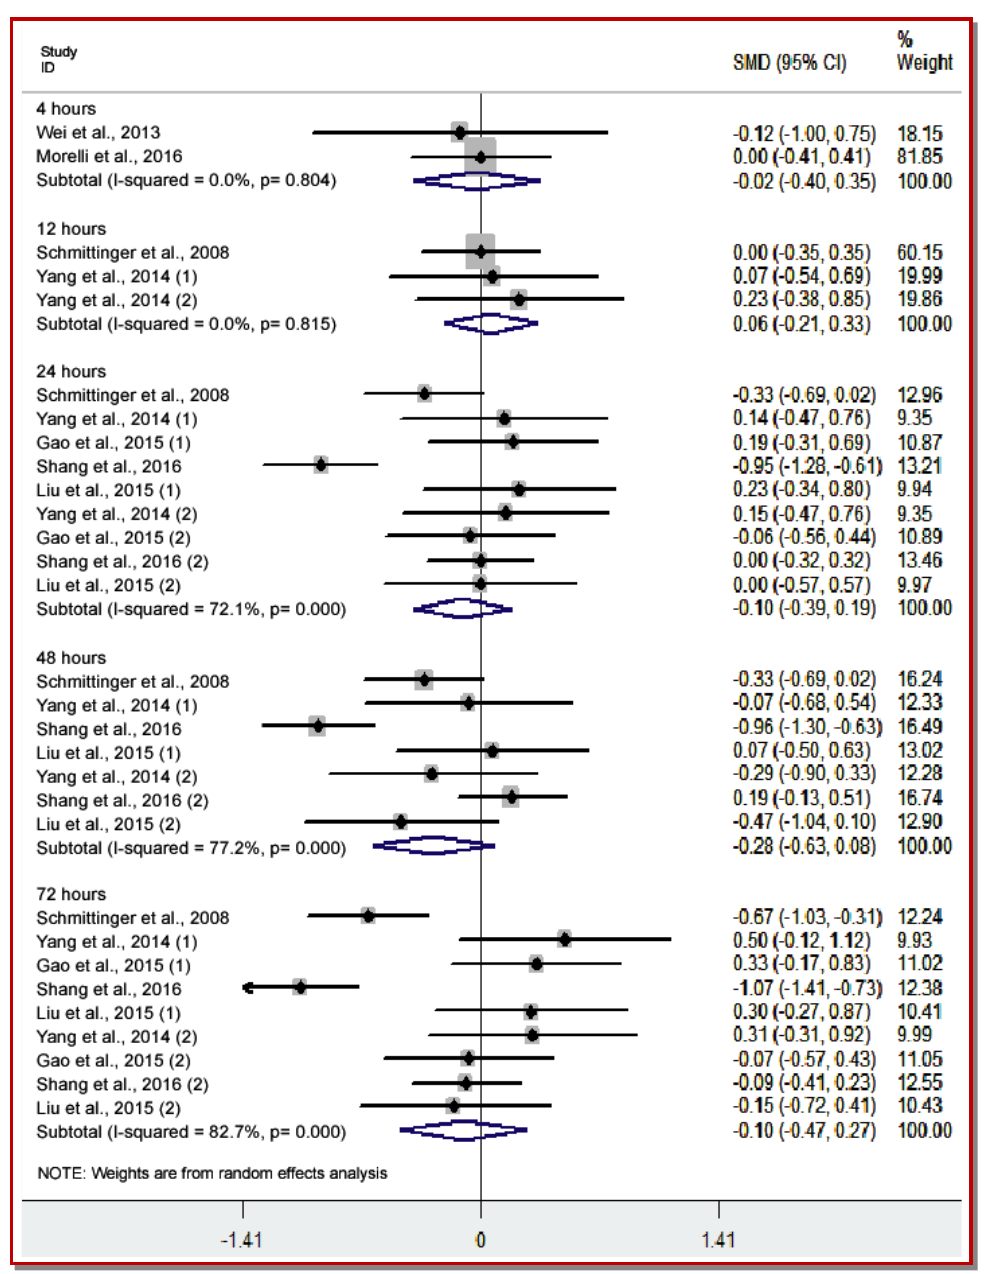
Figure 5: Meta-analysis of beta-blocker on the central venous pressure (digit within the parenthesis means the number of studies for